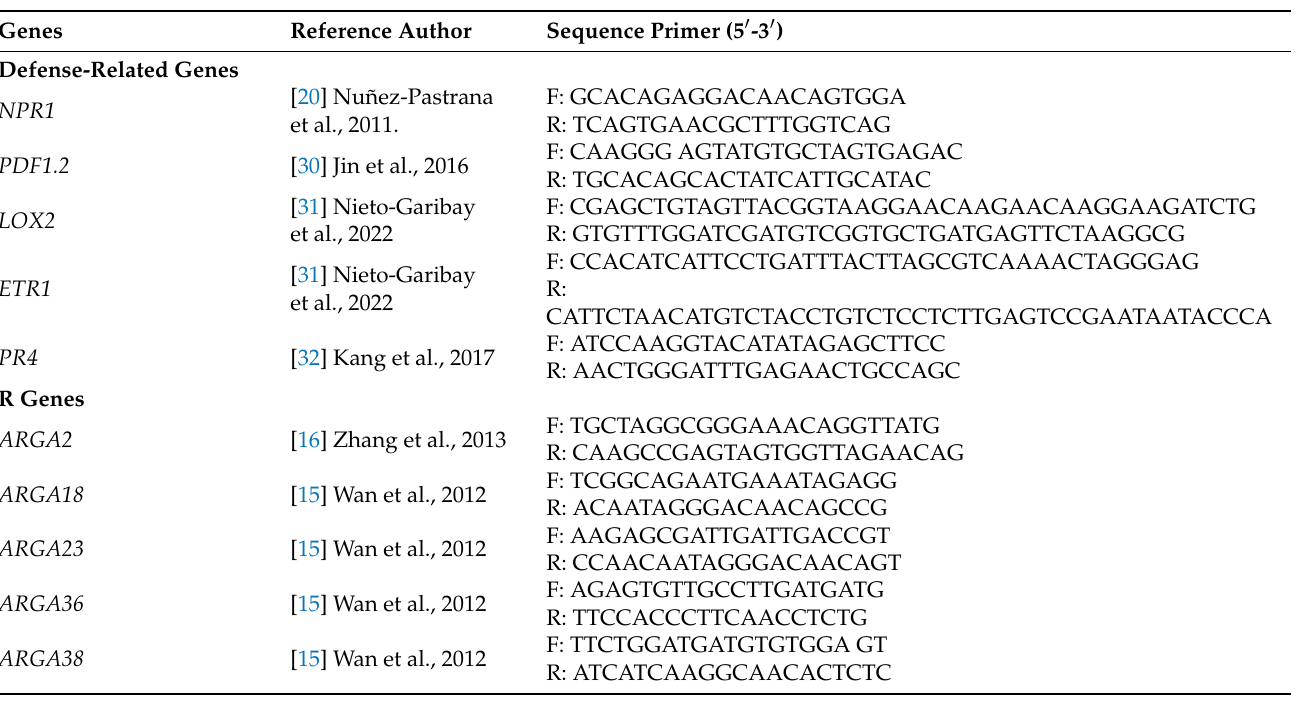
Table 1. Primers used in the